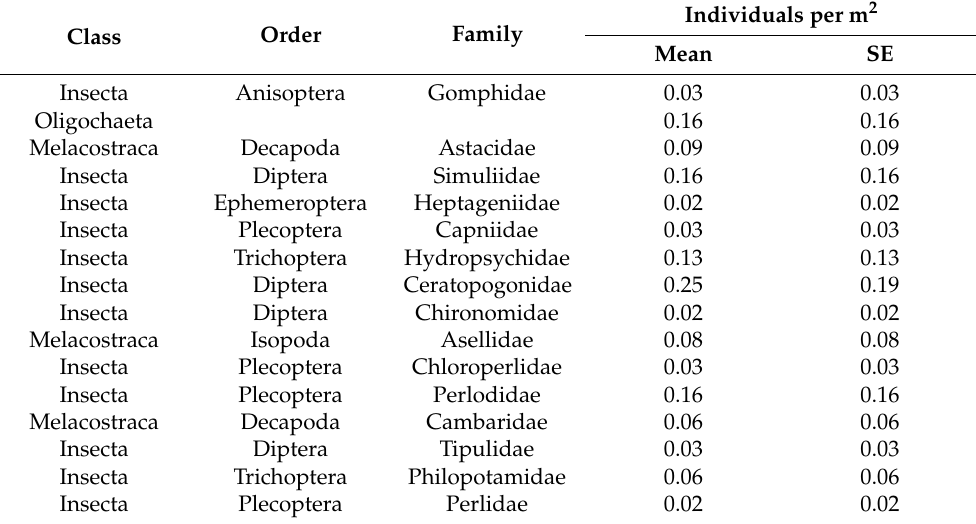
Table 9. Macroinvertebrate assemblages within stream riffles surveyed in Ruby Run at JW Ruby Research Farm in Preston County, West Virginia, USA, from 2018 to 2019. Relative abundance was determined as number of individuals per square meter. All taxa were larval forms aside from Oligochaeta, which consisted of both adults and